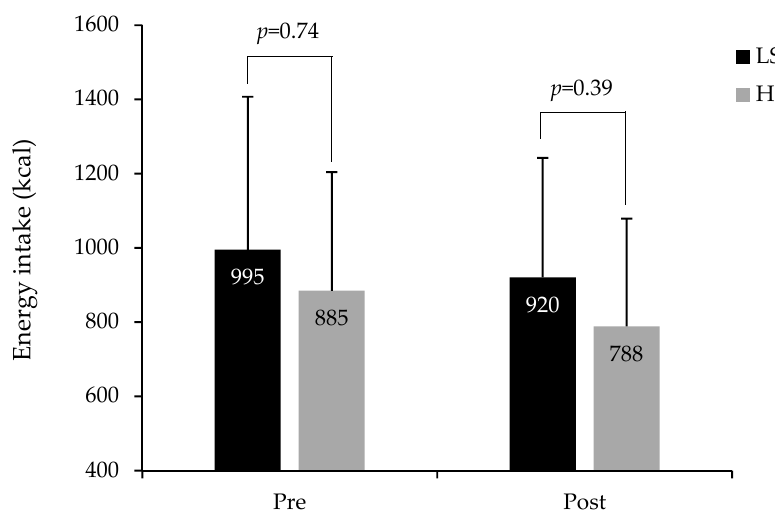
Figure 2. Measured energy intake at the ad libitum buffet-type meal in LSR and HSR groups at baseline (pre) and after the weight loss intervention (post). LSR: Low satiety responsiveness (pre n = 50; post n = 49), HSR: high satiety responsiveness (pre n = 49; post n = 49) (total n = 98 to 99). p values indicate group differences in energy intake as per general linear models (GLM) adjusted for sex and BMI at the related measurement time point. GLM for group difference in post-intervention energy intake was further adjusted for weight loss duration and prescribed energy restriction.